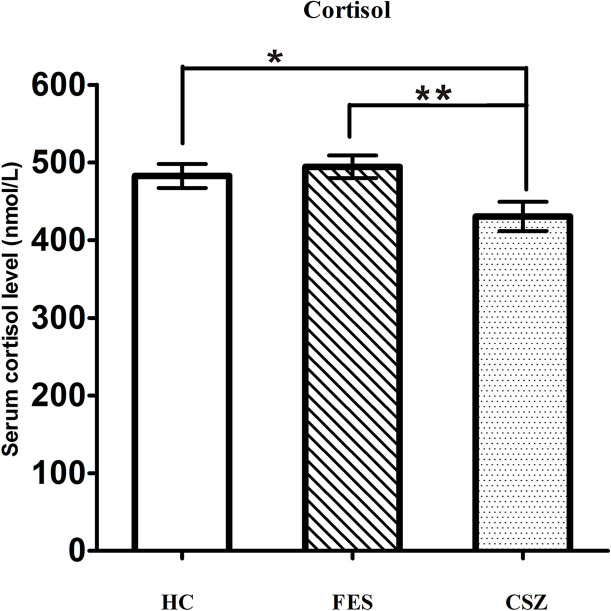
Representative of serum level of cortisol. * means P < 0.05, ** means P < 0.01. Error bars denote mean and SD. FES, first-episode schizophrenia; CSZ, chronic schizophrenia; HC, healthy controls.